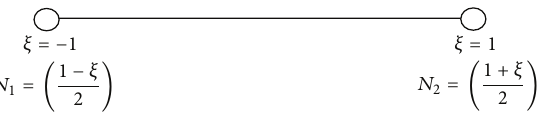
Figure 5: Shape function of bar